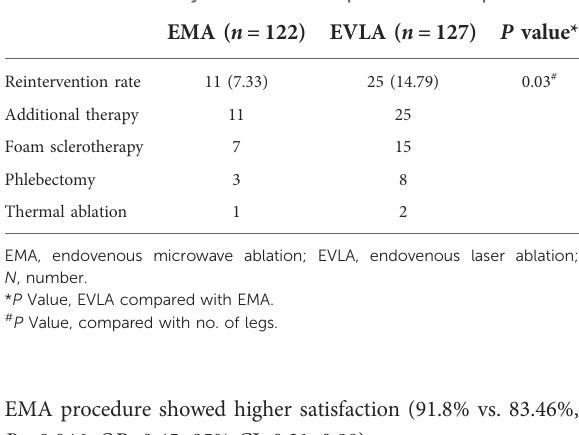
TABLE 3 The secondary outcomes of the patients in both procedures.